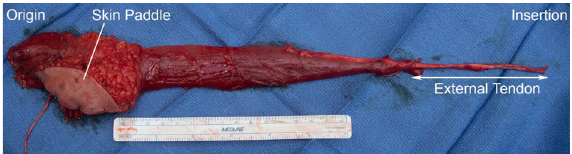
Figure 17. Harvested gracilis MTU. The harvested gracilis is placed on a sterile towel and photographed next to a sterile ruler. Muscle and tendon length are measured from these